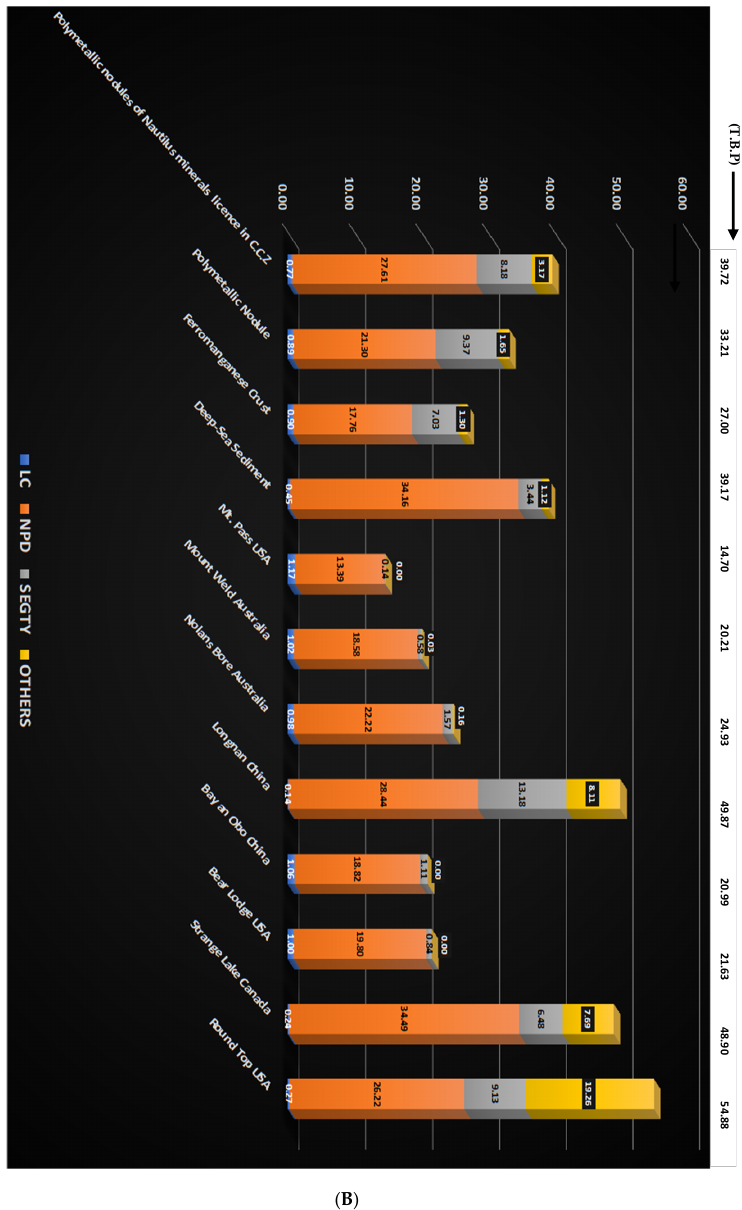
Figure 2. ( A ) Comparative REO values distributions of the studied seabed deposits with terrestrial and under-exploited REEs. LC, La and Ce; NPD, Nd, Pr and Dy; SEGTY, Sm, Eu, Gd, Y and Tb; other REOs, Ho 2 O 3 , Er 2 O 3 , Yb 2 O 3 and Lu 2 O 3 (Tm 2 O 3 excluded due to its very low values); TREO, total rare earth oxide (data from Table 6). ( B ) (TBP) in US$/kg (prices in May 2021) of the REOs from seabed and land-based REE deposits. LC, La and Ce; NPD, Nd, Pr and Dy; SEGTY, Sm, Eu, Gd, Y and Tb; OTHERS, Ho 2 O 3 , Er 2 O 3 , Yb 2 O 3 and Lu 2 O 3 (Tm 2 O 3 excluded due to its very low